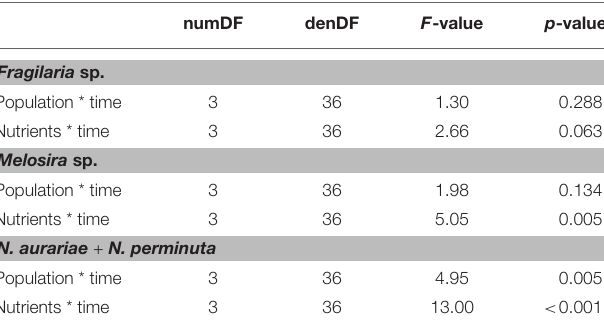
TABLE 3 | ANOVA output from the mixed models on the benthic algae. numDF denDF F -value p -value Fragilaria